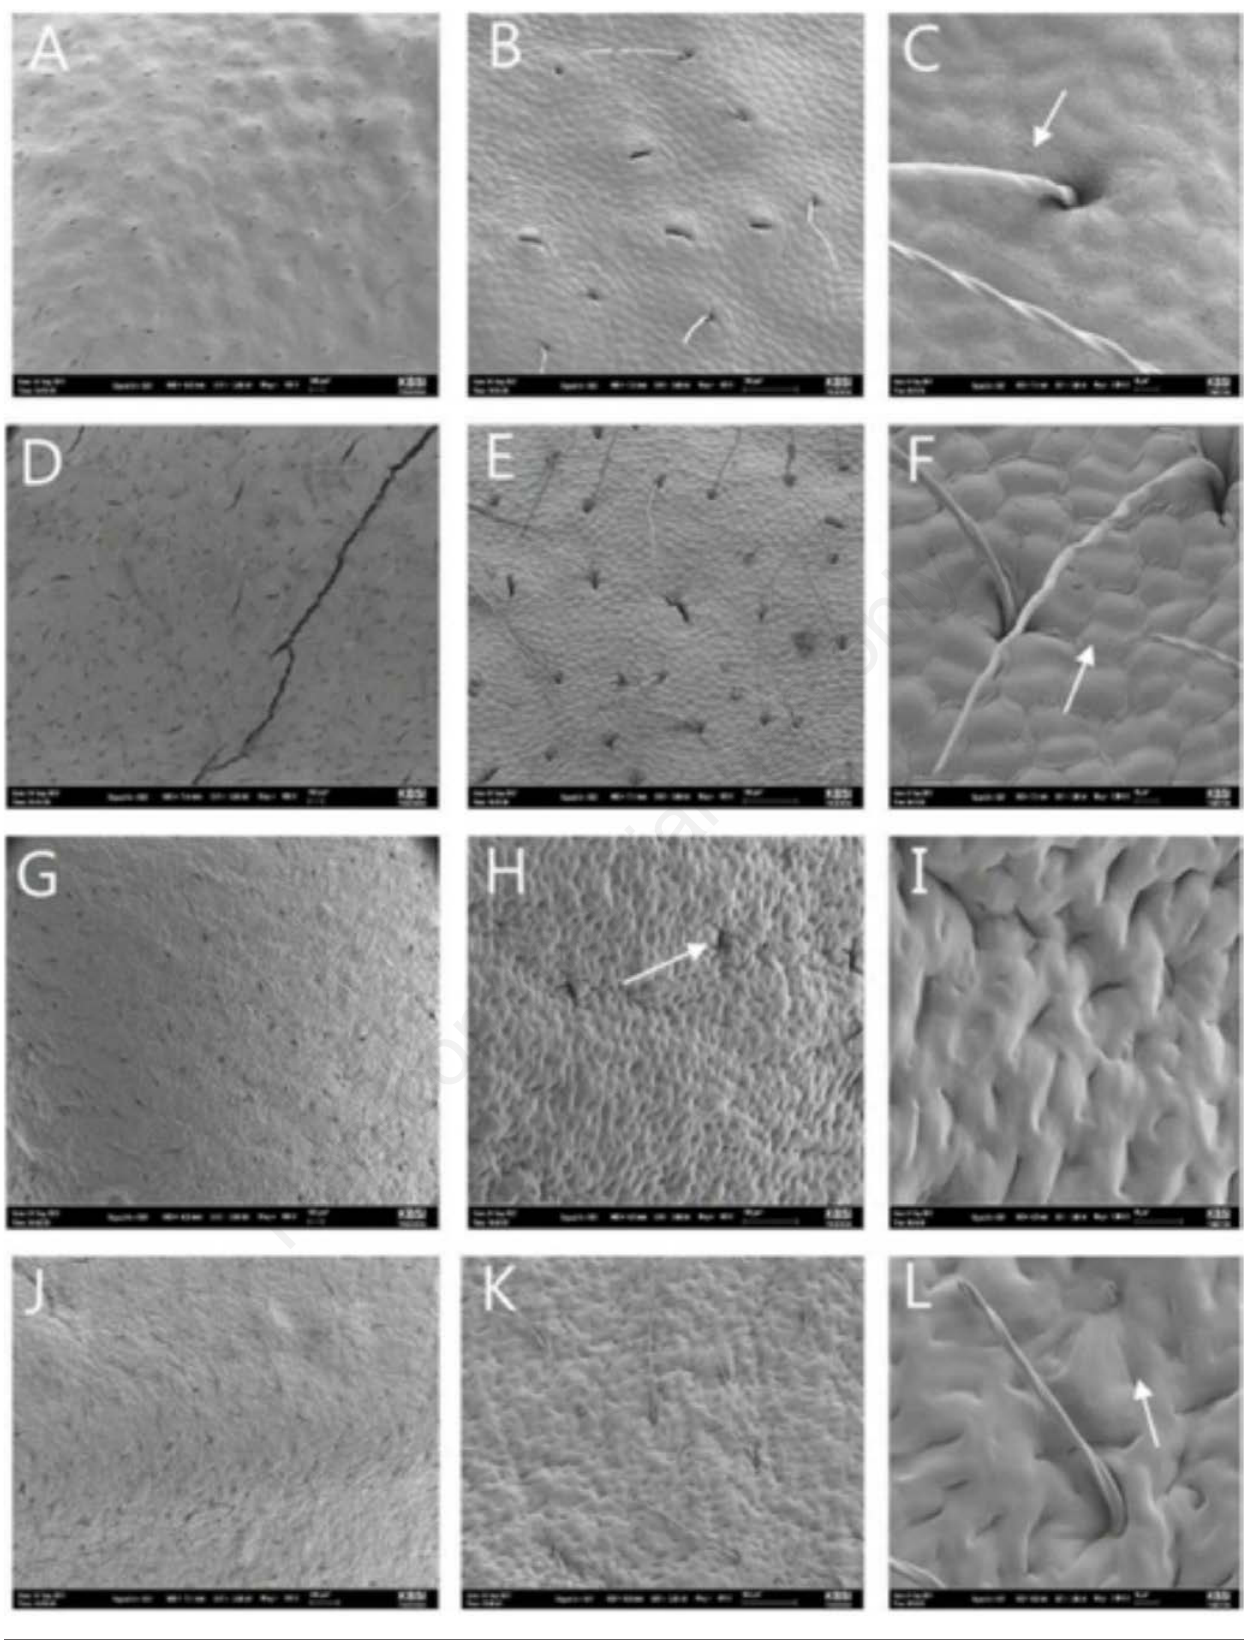
Figure 3. Seed morphology of Calycanthaceae from SEM. A-C, Chimonanthus fragrans ; D-F, Chimonanthus saliicifoliu s; G-I, Chimonanthus yunnanensi s; J-L Chimonanthus luteus . (Trichome, E, H, K; Seed surface C, F, I,